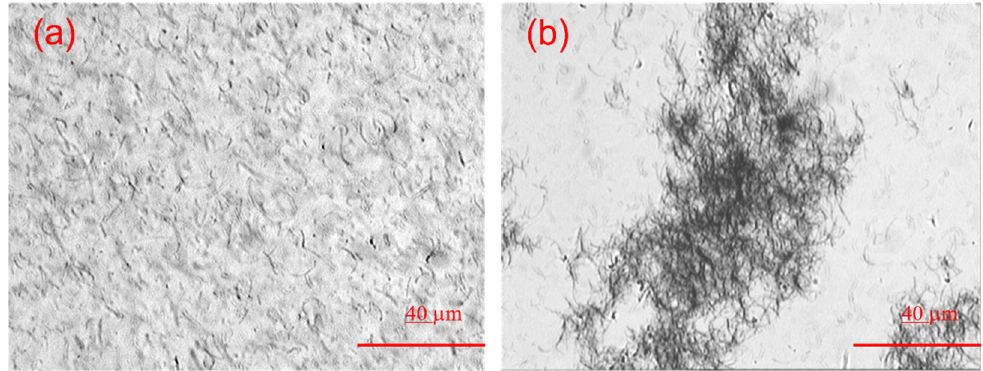
Figure 3. CNT solution in trichloromethane ( a ) 1 min after the end of the ultrasonication, ( b ) 30 min after the end of the